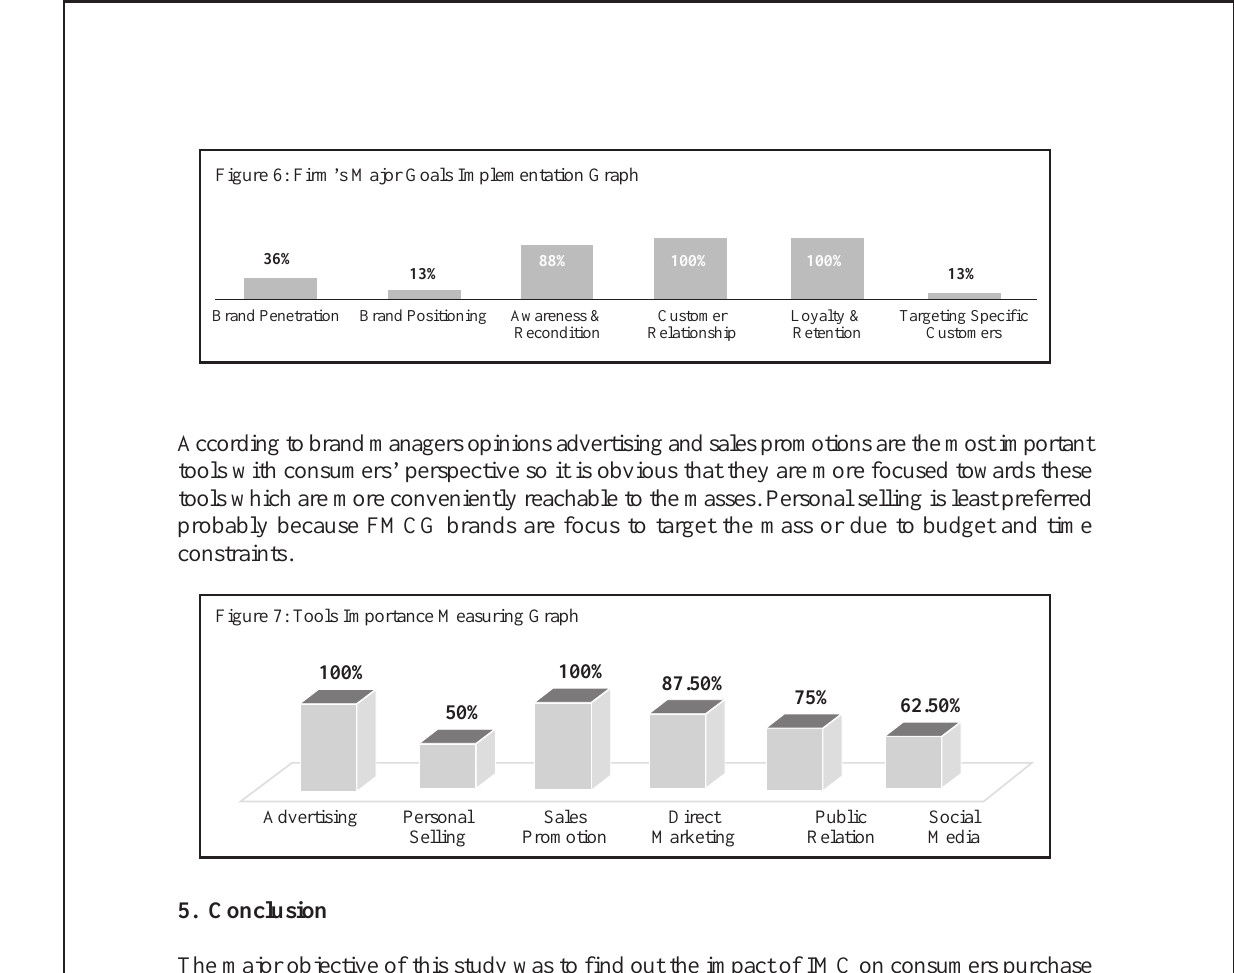
Figure 6: Firm’s Major Goals Implementation Graph